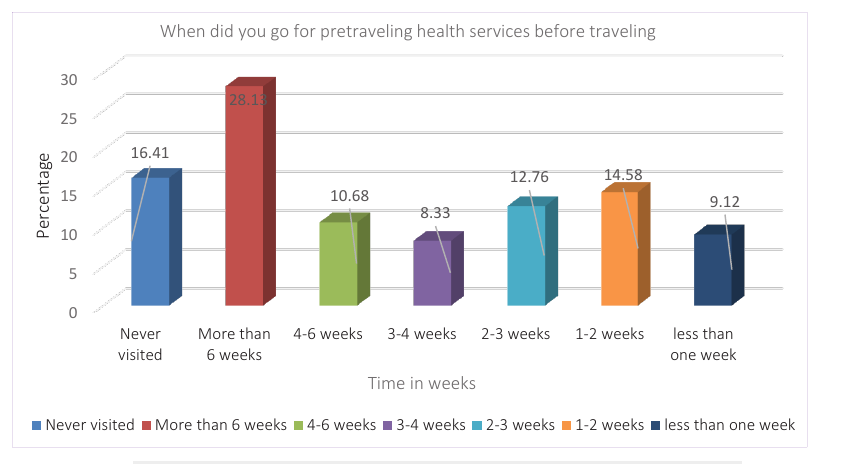
Figure 7 . Time of Seeking Health Advice Prior to Departure (n=380).